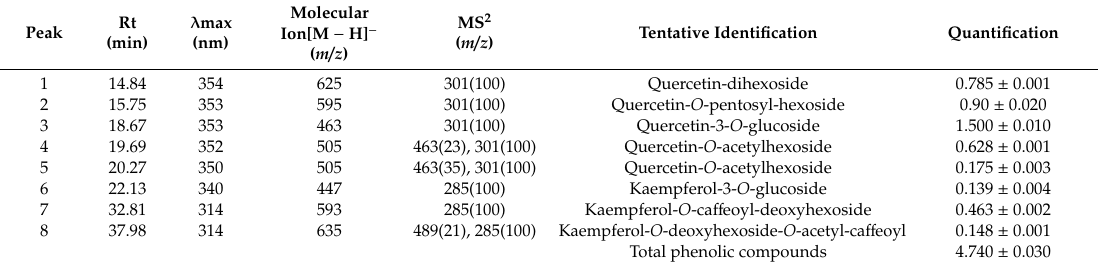
Table 4. Retention time (Rt), wavelengths of maximum absorption in the visible region ( λ max), mass spectral data and tentative identification, and phenolic compounds quantification (mg g of extract) in okra